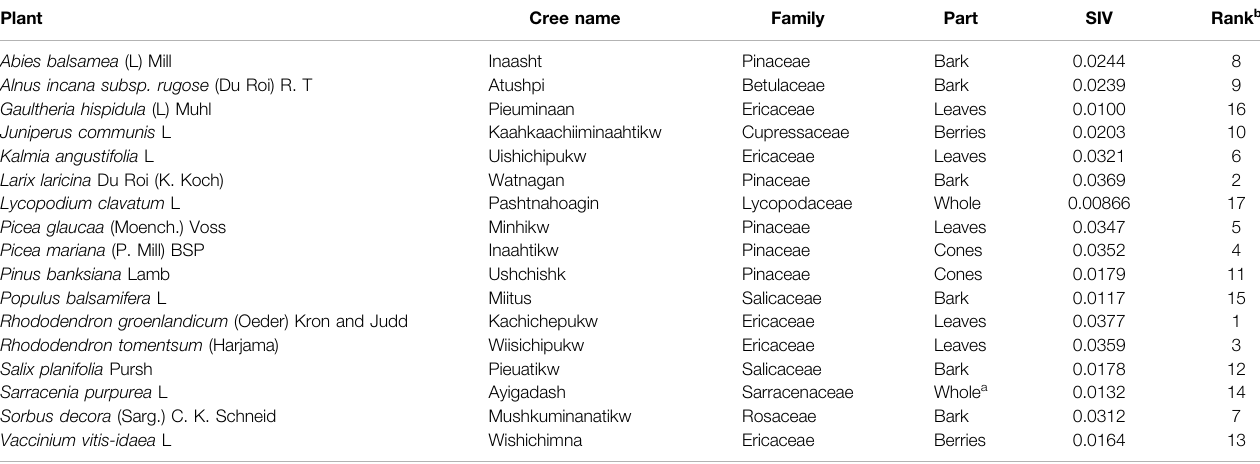
TABLE1| The17mostimportanttraditionalmedicinalplantsofmorethan50plantsmentionedforthetreatmentofdiabeticsymptomsandcomplicationsamongtheCreeof Eeyou Istchee as identi fi ed through interviews with elders.